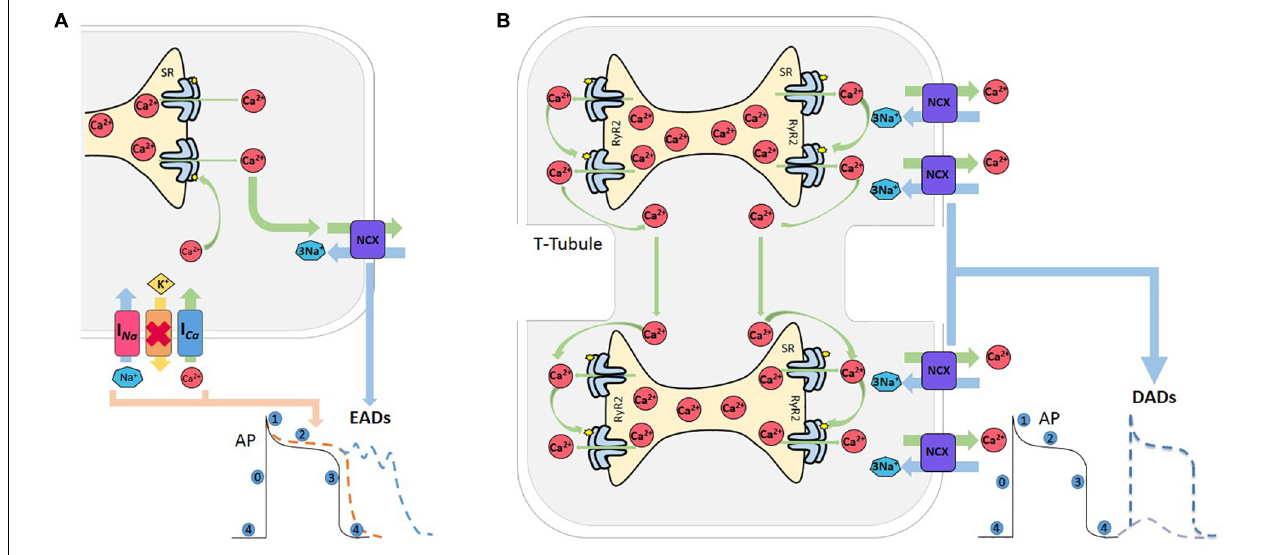
FIGURE 3 | Afterdepolarizations. (A) Reactivation of L-type Ca 2 + current (I Ca ) during prolongation of the AP, mainly during phase 2 or 3, increases the propensity for EADs. The Na + -Ca 2 + current (NCX) also meets the criterion needed for the positive feedback required for an EAD to occur. Both currents can act synergistically facilitating EAD formation, and thus increasing the probability of an EAD-triggered AP. Red cross indicates inhibition of K + channels. (B) Various conditions which increase SR-Ca 2 + and/or sensitize RyR2 can induce spontaneous Ca 2 + release from the SR. When this release achieves certain critical mass, Ca 2 + can induce a saltatory propagation along cell sarcomeres, known as Ca 2 + waves, which in turn activates the NCX that extrude 2 Ca 2 + and enter 3 Na + , depolarizing the cell membrane and producing a delay after depolarization (DAD). If this depolarization attains the excitability threshold, a spontaneous AP